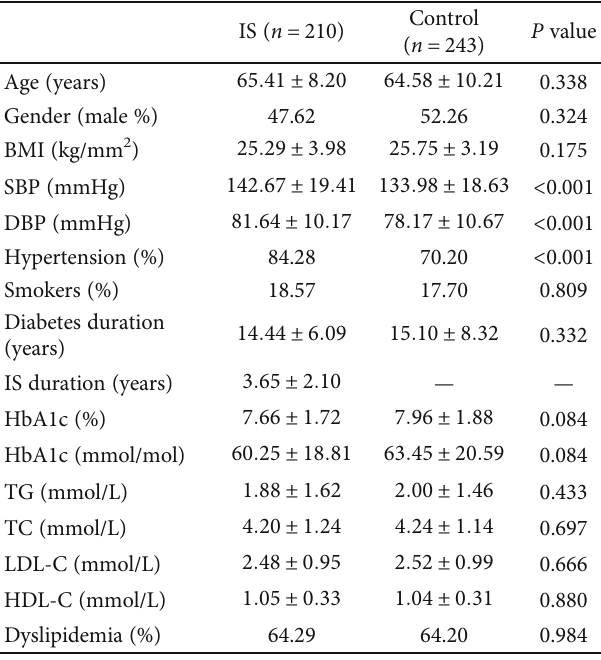
Table 1: Demographic, clinical, and biochemical data of the IS and the control